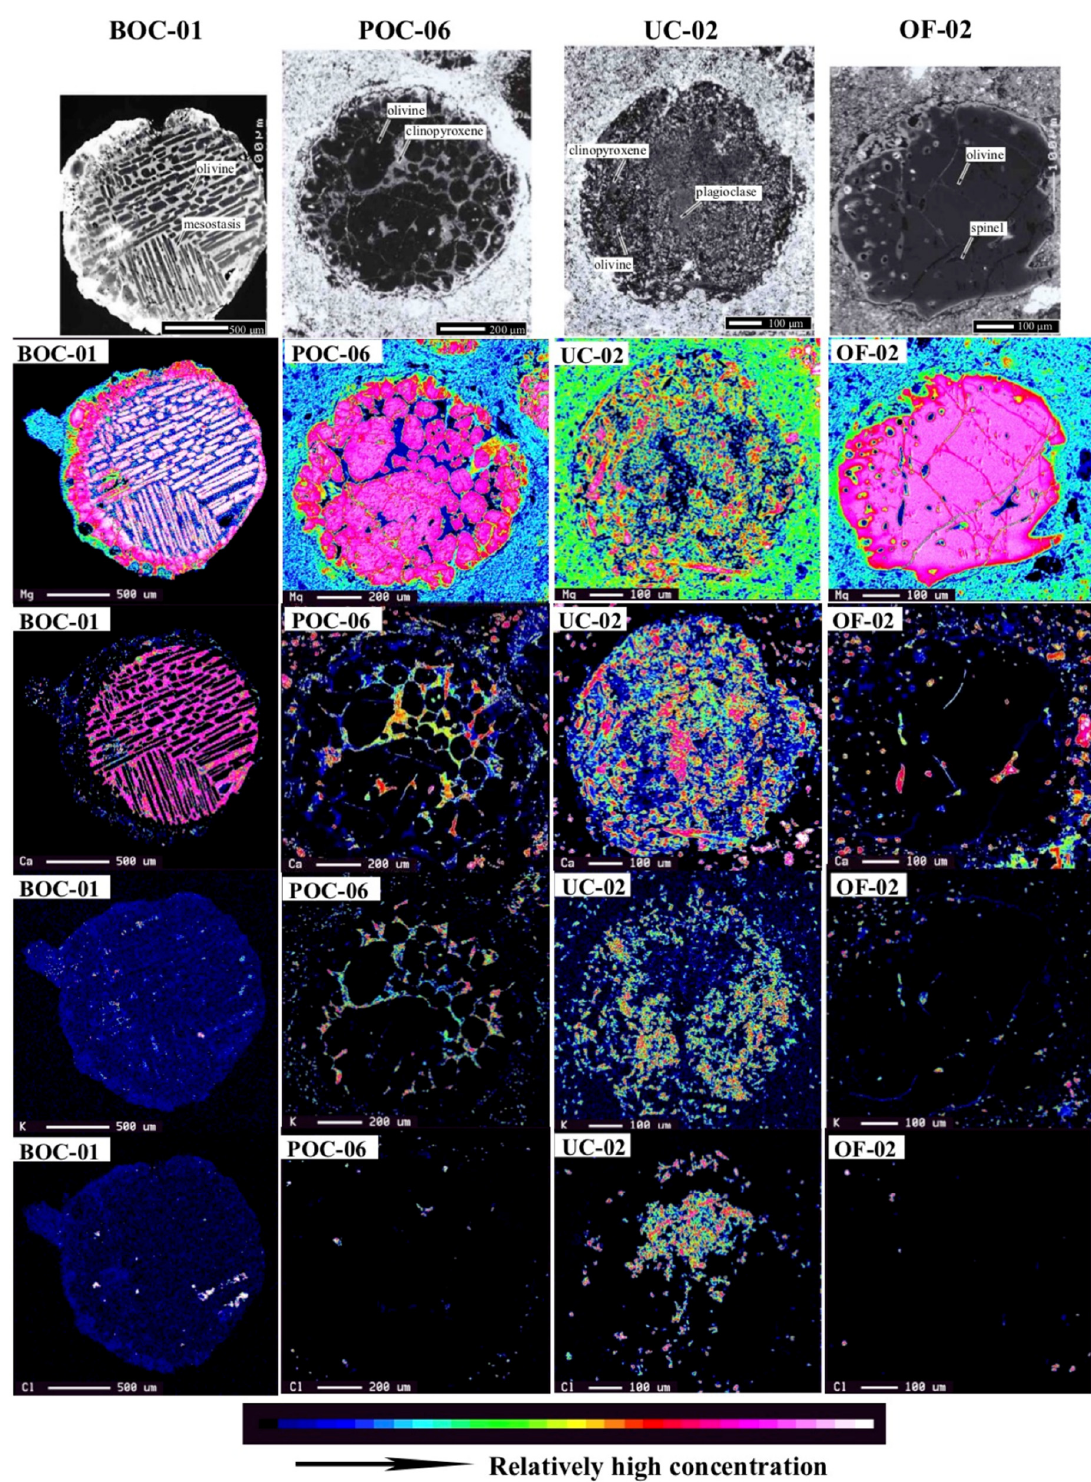
Figure 2. BSE images and Mg–Ca–K–Cl X-ray maps of the representative objects, barred olivine chondrule (BOC-01), porphyritic olivine chondrule (POC-06), unclassified chondrule (UC-02), and olivine fragment (OF-02).